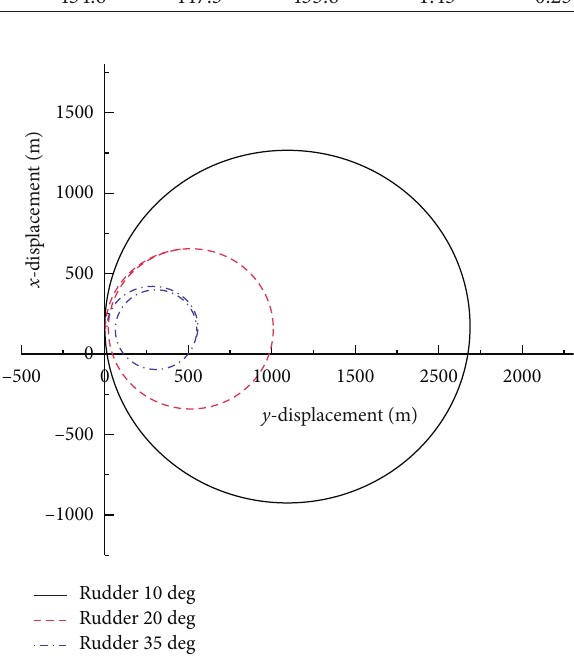
Figure 9: Ship roll tracks for different rudder